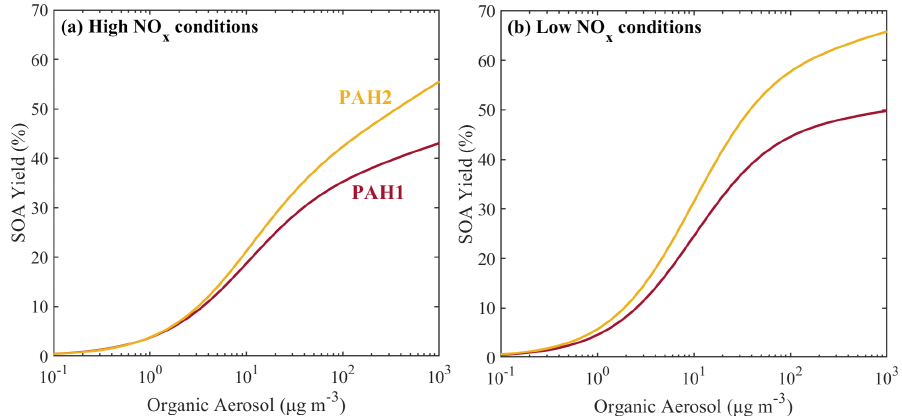
Figure 10. Estimated aerosol mass fractions of the new lumped PAH species under (a) high-NO x and (b) low-NO x conditions. The yield curves are generated using the mass-based yields of Table 3. Table 3. Aerosol mass-based yields for the new lumped species in the IVOC range using a five-product basis set with saturation concentrations of 0.1, 1, 10, 100 and 10 3 µgm − 3 at